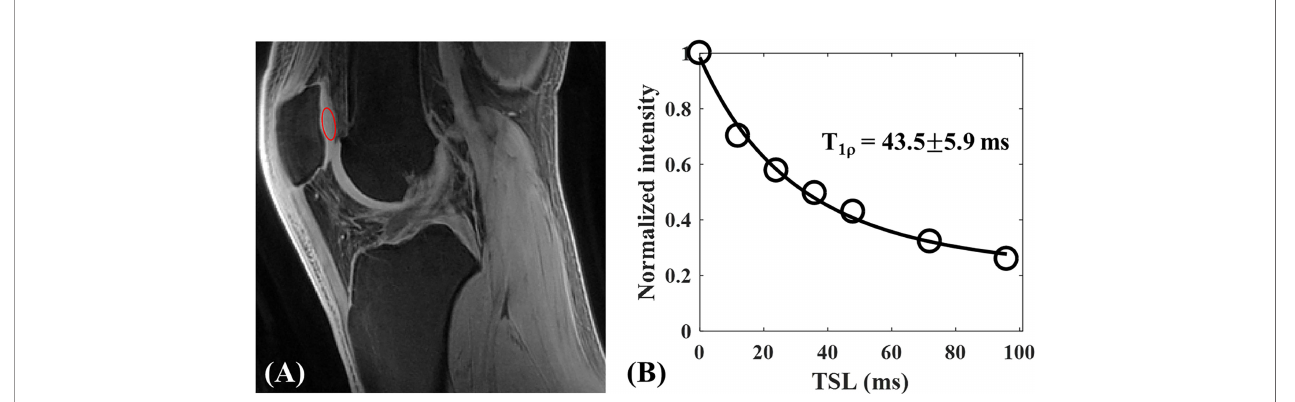
FIGURE 13 | 3D UTE-AdiabT 1 r Cones imaging of an in vivo knee from a 23-year-old healthy male volunteer. Representative AdiabT 1 r image (A) with region of interest (ROI) (red circle) and corresponding fi tting curve (B) of patellar cartilage are demonstrated. The T 1 r value of patellar cartilage was obtained with 43.5 ± 5.9 ms. Modi fi ed, with permission from